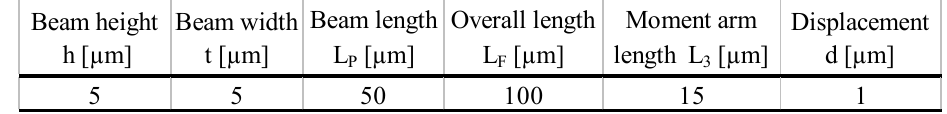
Table 1: Dimension of the mocrotweezers in figure 2 and